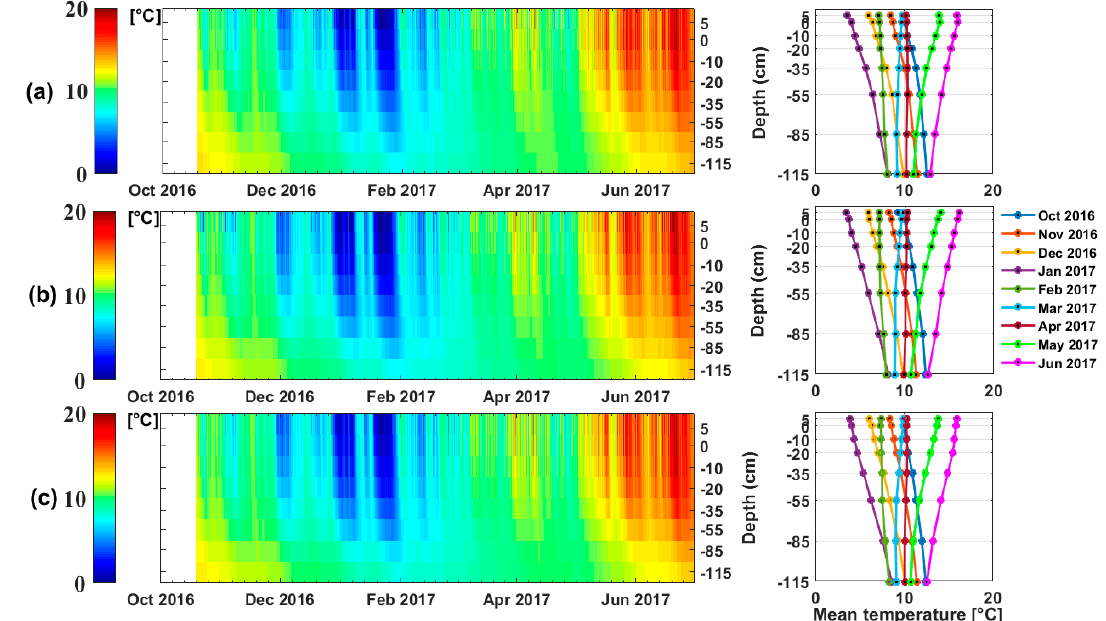
Figure 5. Thermal profiles along the hyporheic zone at locations with no groundwater inflows detected ( left ) at a time-step of 5 min or ( right ) as monthly means in the ( a ) wetland sub-reach (upstream), ( b ) interface between wetland and woods sub-reaches, and ( c ) swamp sub-reach (downstream).